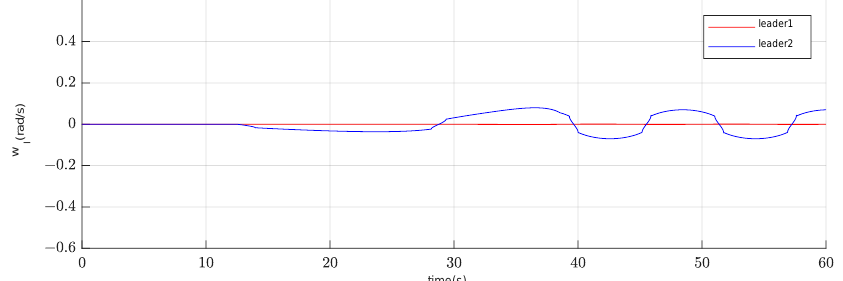
for the leaders during the movement. 𝑣𝑣 𝑙𝑙